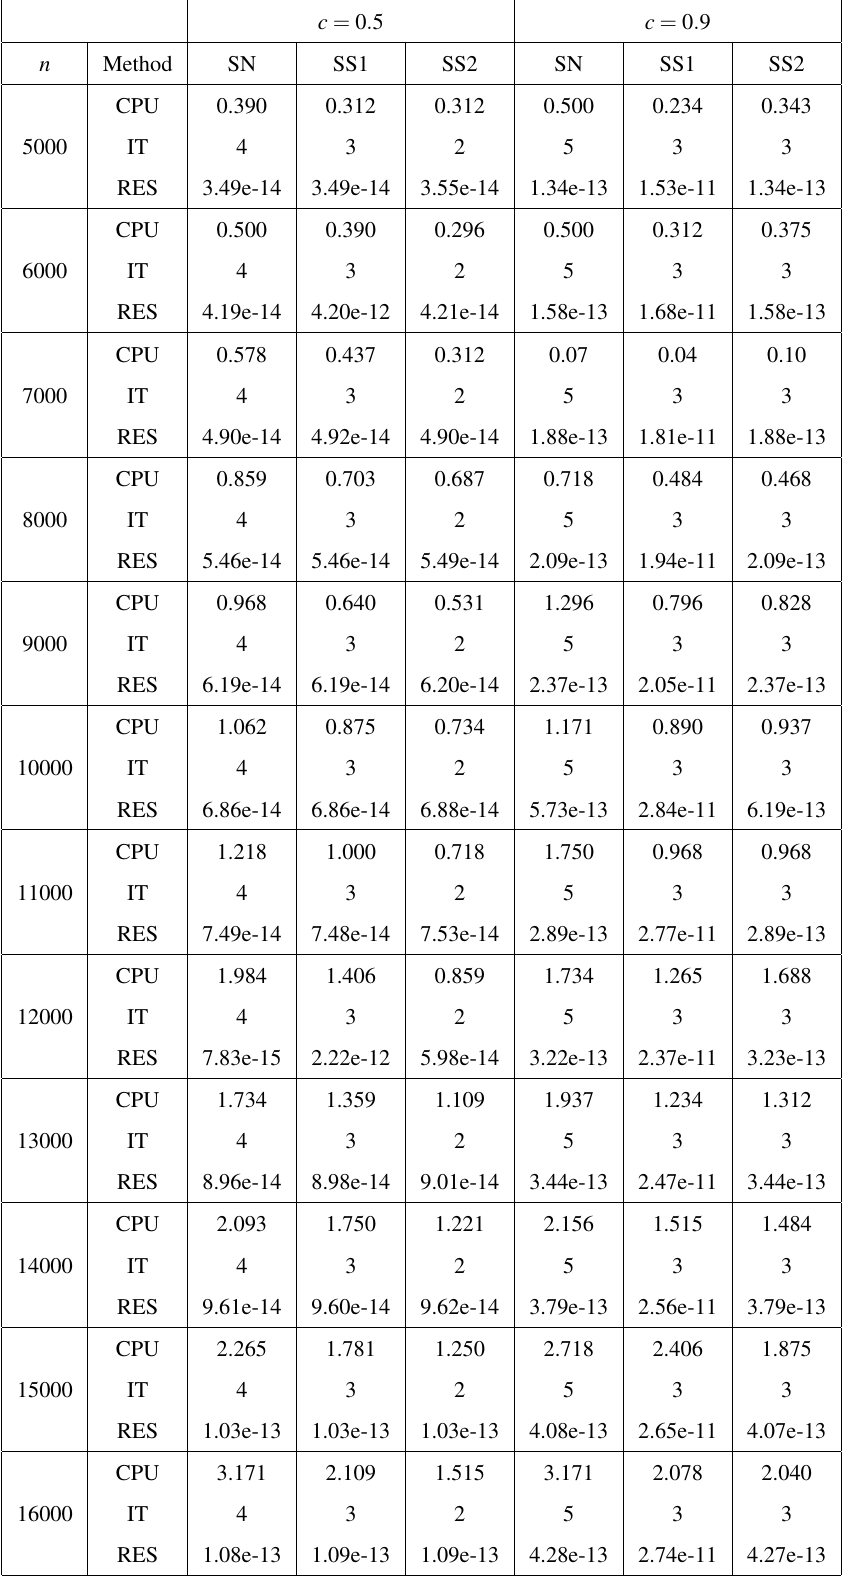
Table 1. Test results for c = 0 . 5 and c = 0 .